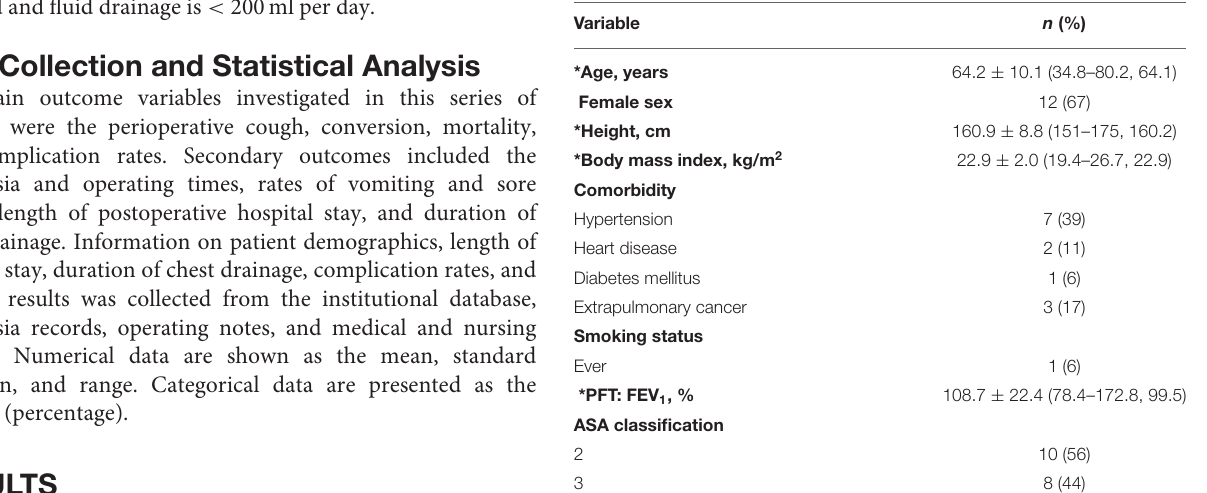
TABLE 1 | Patient demographic and clinical